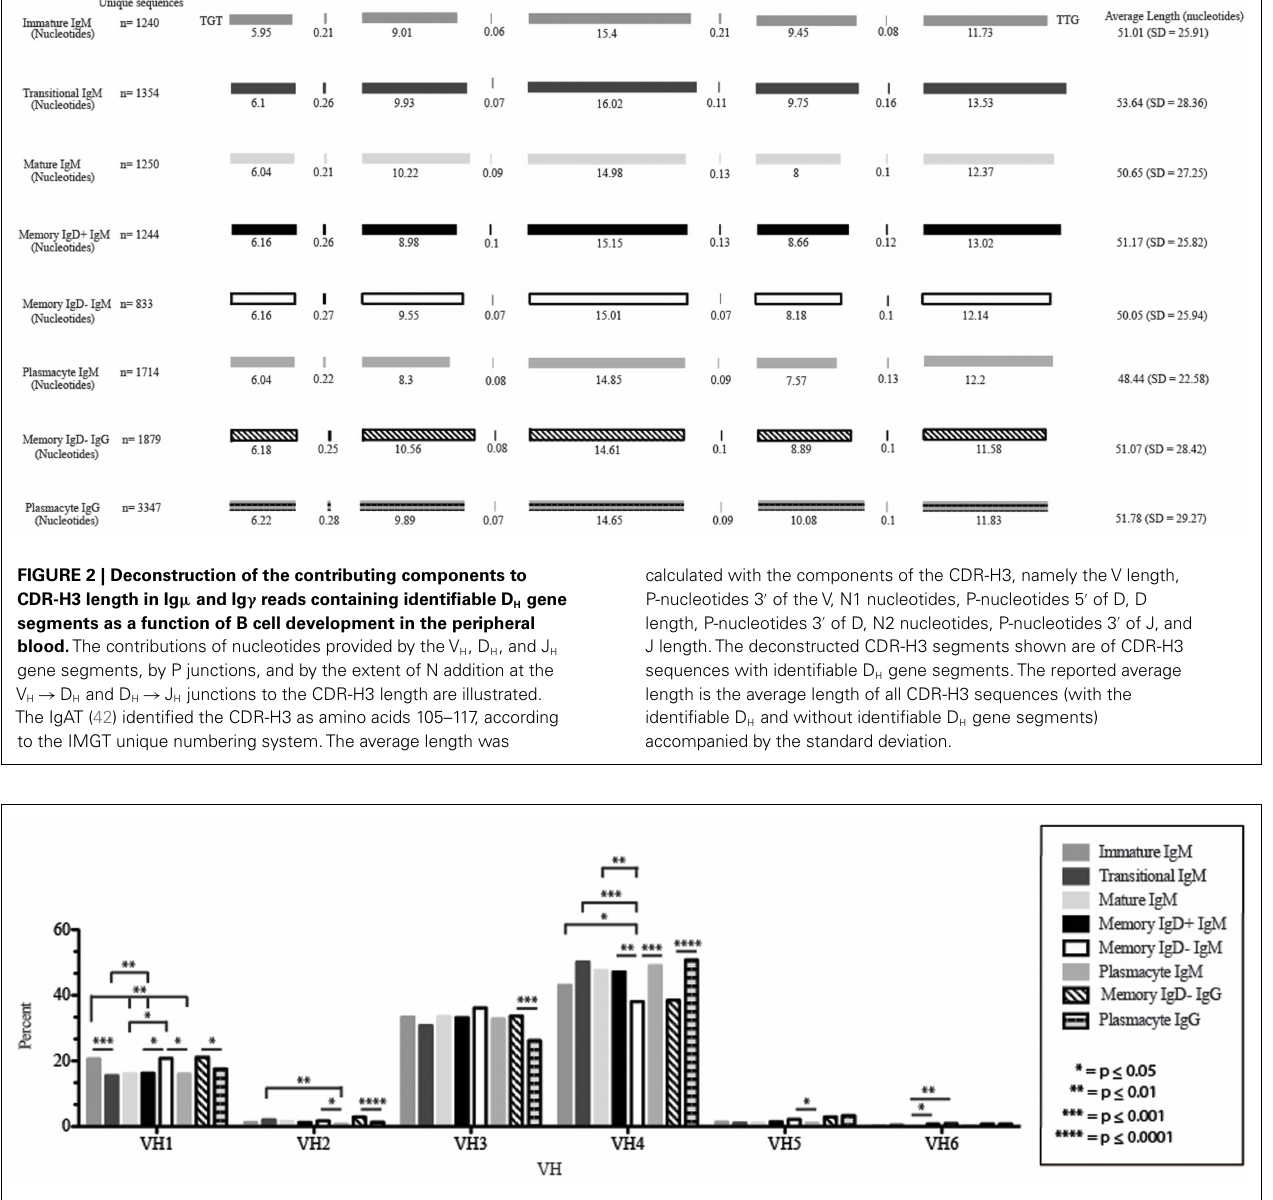
transitional, mature, memory IgD + , memory IgD − B cells, and plasmacytes are displayed. All comparisons were made using χ 2 -test or Fisher’s exact test as appropriate. Significant differences among each fraction in the different mice are indicated by asterisks: * p ≤ 0.05, ** p ≤ 0.01, *** p ≤ 0.001, **** p ≤